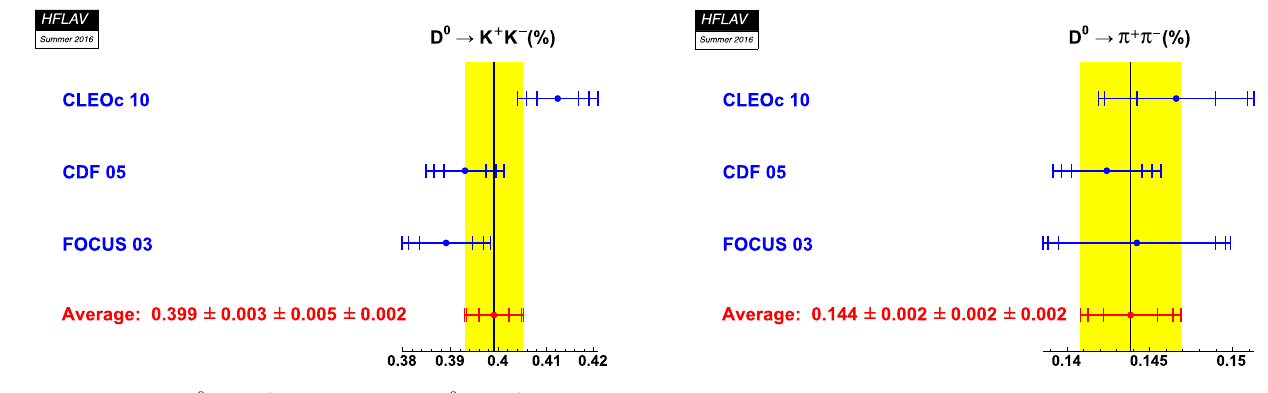
systematic and K π normalization uncertainties. The average obtained here ( red point , yellow band ) lists the statistical, systematics excluding FSR, and the FSR systematic